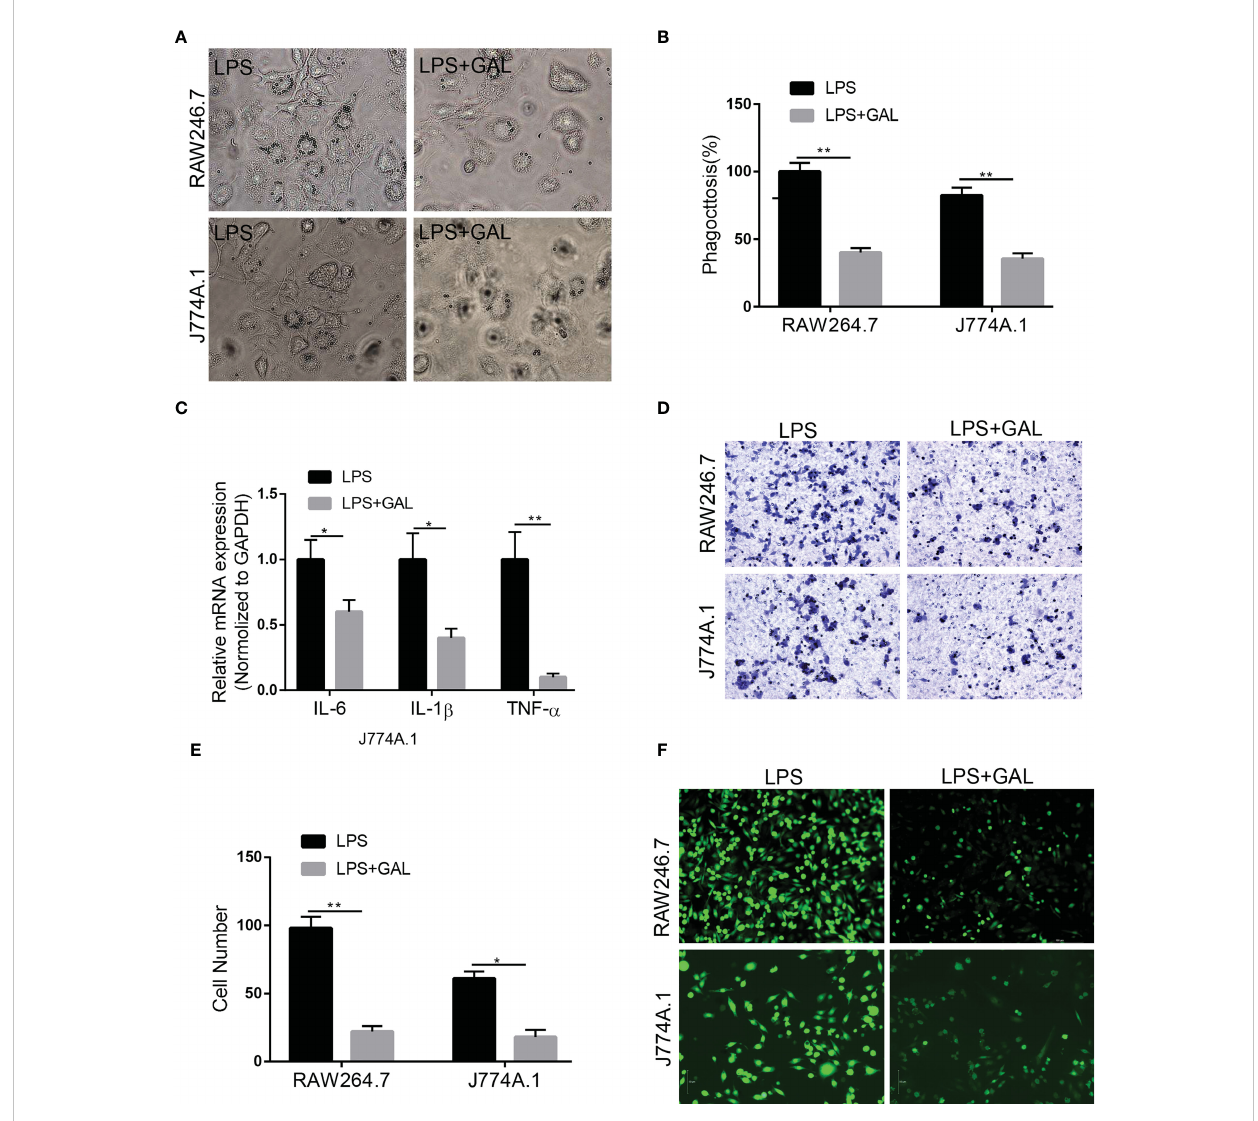
FIGURE 4 Galanin improves in fl ammation in murine macrophages. Murine macrophages were incubated with LPS to induce in fl ammation, and treated with or without galanin(1000nmol/L). (A) Representative images showing the internalization of latex beads by J774A.1 and RAW264.7 cells. (B) Quantitative analysis of (A) **, p < 0.01. (C) IL-6, IL-1 b and TNF- a mRNA levels in J774A.1 macrophages assessed by qRT-PCR. *, p < 0.05, **, p < 0.01. (D) Transwell assay on J774A.1 and RAW264.7 macrophages to investigate the effect of galanin on migration. (E) Quanti fi cation of (D) *, p < 0.05.